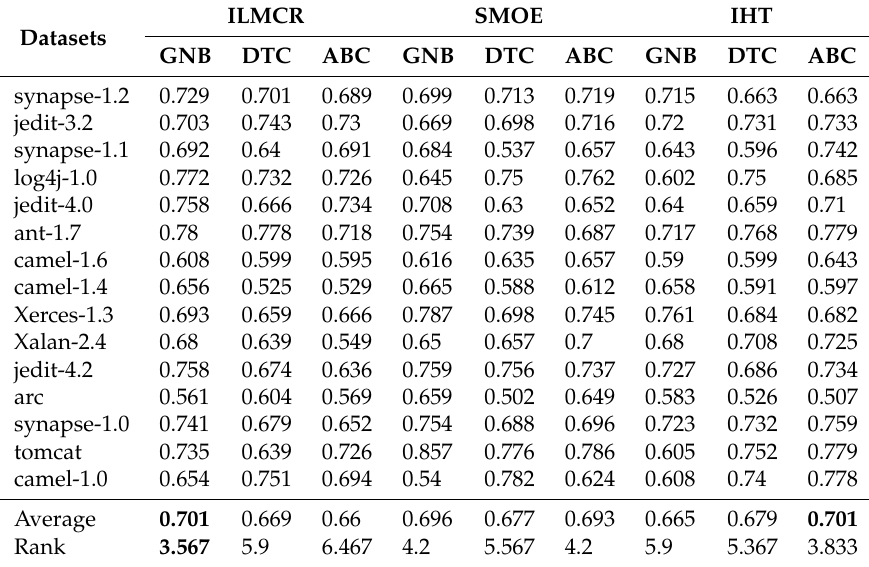
Table 11. Balancedscore of matching of classifiers with resampling methods on small datasets.